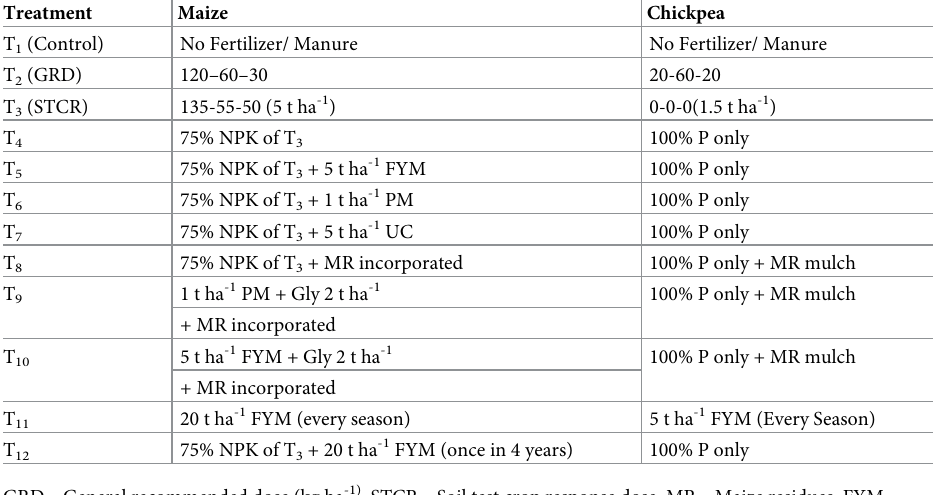
Table 1. Treatment details in maize-chickpea cropping